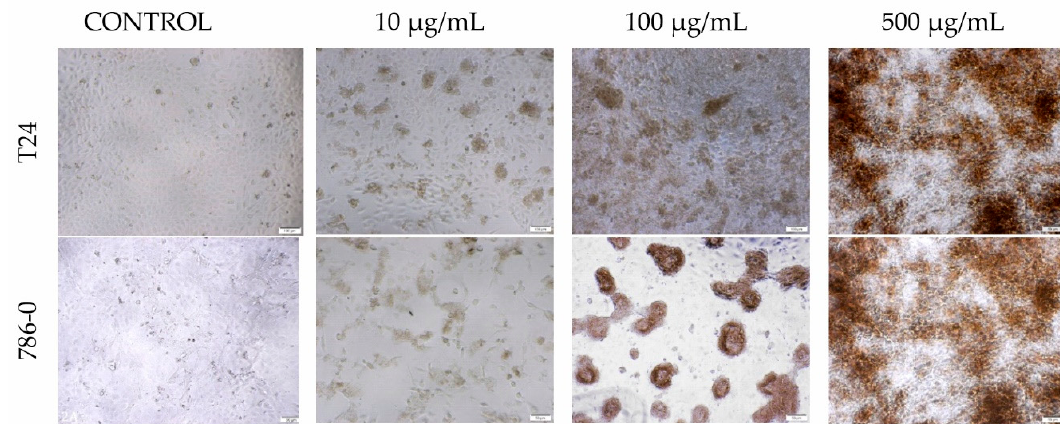
Figure 9. Morphology of T24 and 786-0 cells after 72 h incubation. Magnification ×50. In the case of